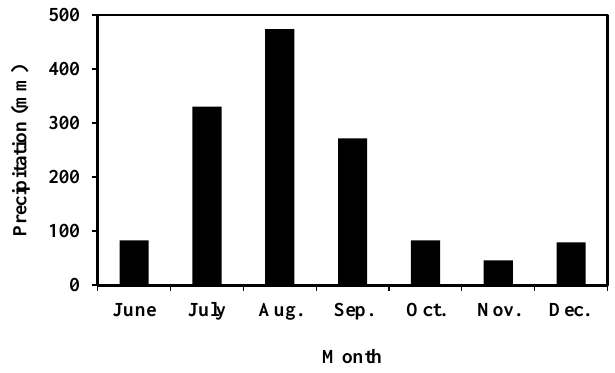
Figure 2. Monthly integrated precipitation at Gwangju during 2012.